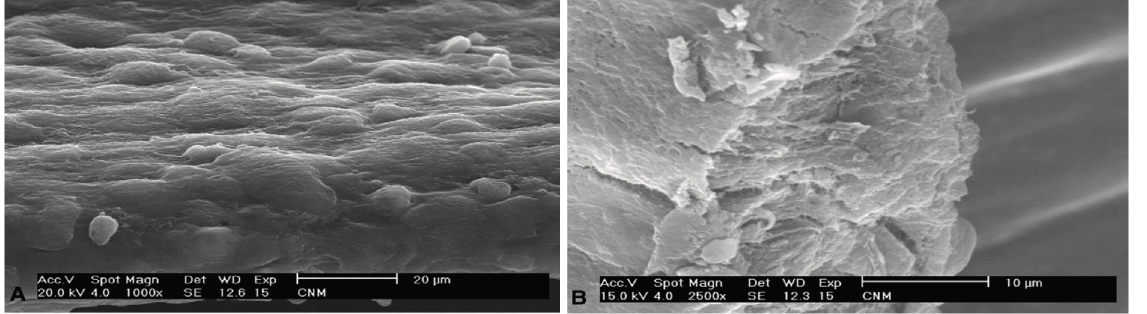
Figure 12. SEM images of a five layered graft showing dense cell growth after two weeks of culture. Reprinted with permission from [125], Copyright © 2005 by The American